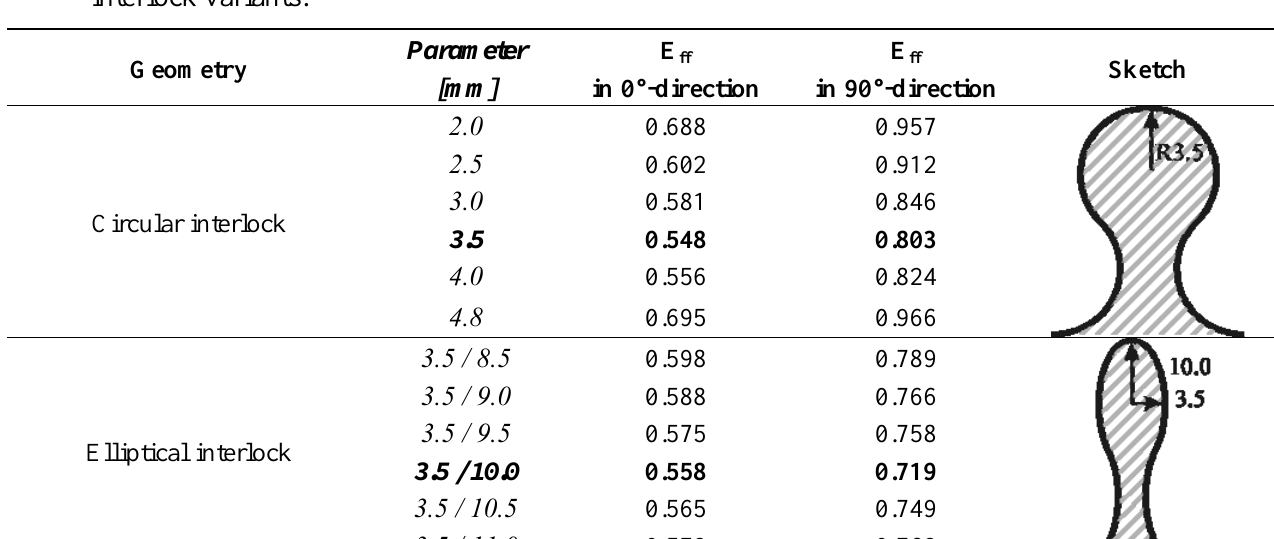
Table 5. Resultant stress efforts depending on the radius parameter of 10 mm wide interlock variants.